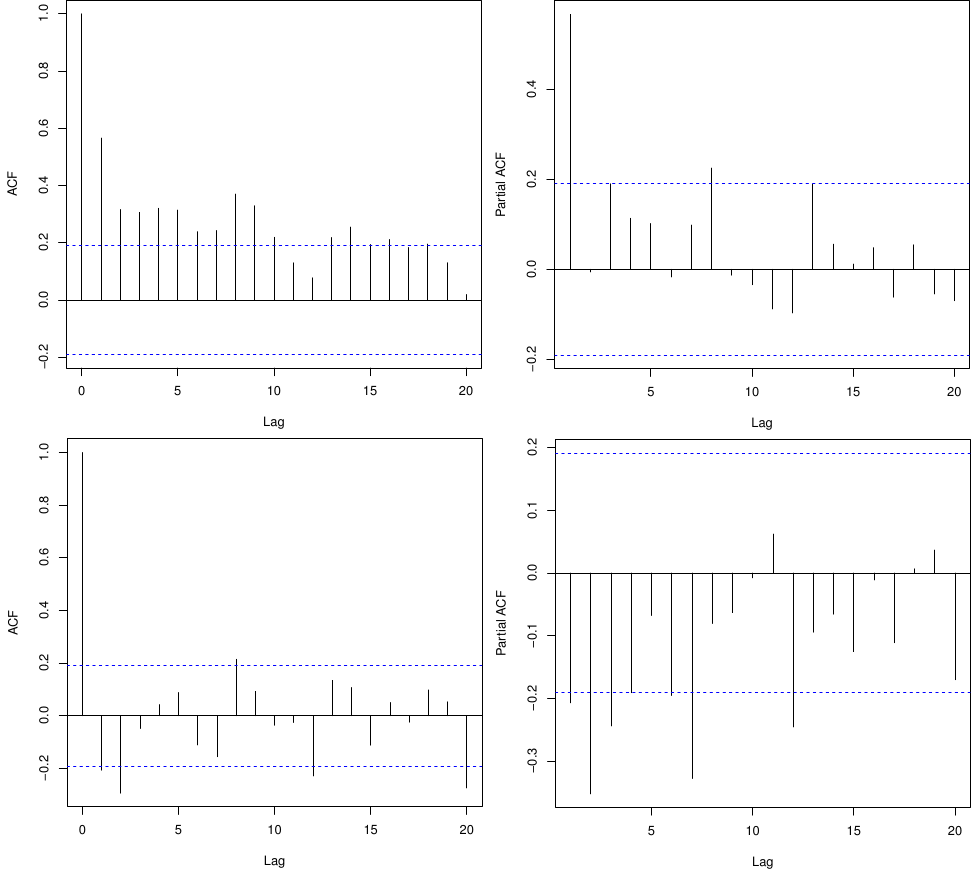
Figure 10. ACF and PACF for level ( first row ) and differenced data ( second row